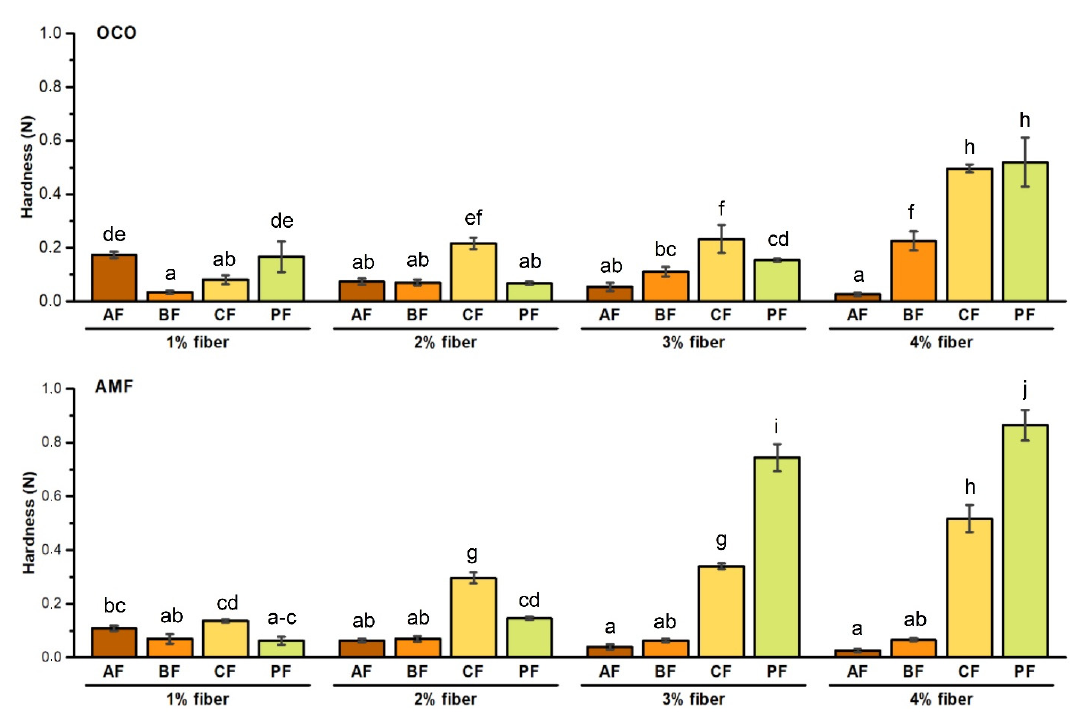
Figure 1. Effect of fiber type and concentration on hardness of PCS (processed cheese sauces) obtained on the basis of AC (acid casein) and WPC80 (whey protein concentrate) with OCO (organic coconut oil) or AMF (anhydrous milk fat). Letters (a–j) indicate significant differences at p < 0.05.